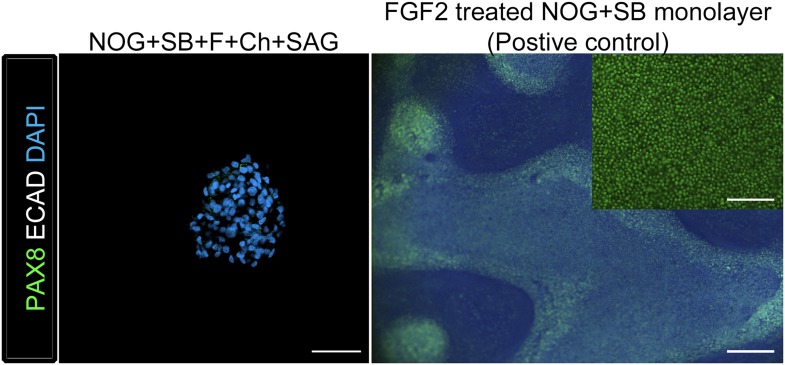
Ventral foregut spheroids do not express appreciable levels of PAX8 protein.Although NOG+SB+FGF4+Ch+SAG ventral foregut spheroids expressed PAX8 mRNA (Figure 3B), we did not detect PAX8 protein in spheroids using immunofluorescence, whereas PAX8 protein in FGF2 8 day treated foregut monolayers (ACTA followed by NOG/SB) was readily detectable. Left panel: scale bar represents 50 µm. Right panel: scale bar represents 200 µm, inset scale bar represents 100 µm.